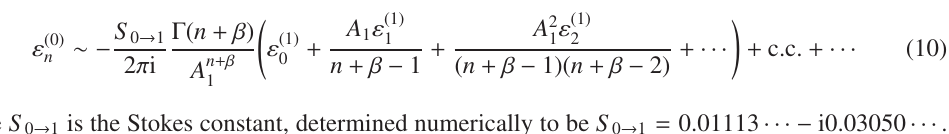
Figure 2. Poles of the Borel-Padé approximant BP 189 , A , 2 A , 2 A ξ = A 1 1 1 1 (blue dots),